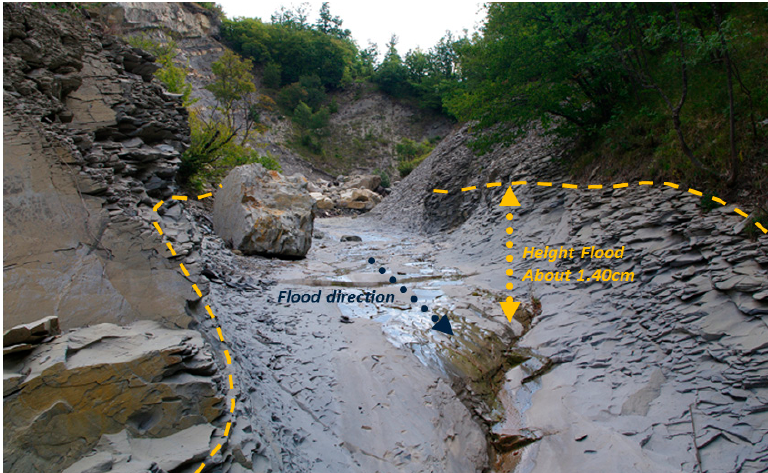
Figure 10. Example of erosive forms in the riverbed. The alluvial deposits that filled the channel before the event were completely removed, causing the exposure of the marly substrate (Late Cretaceous Helmintoid Flysch).